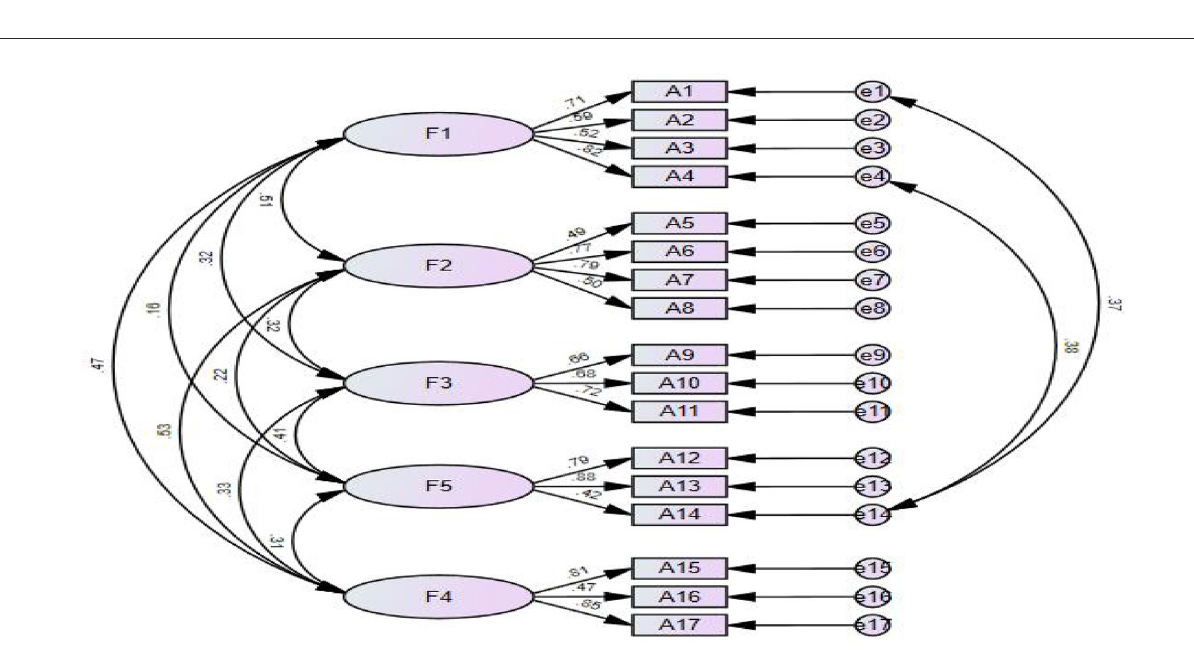
FIGURE2 Standardized five-factor structural model of the self-care scale for older adults undergoing hip fracture